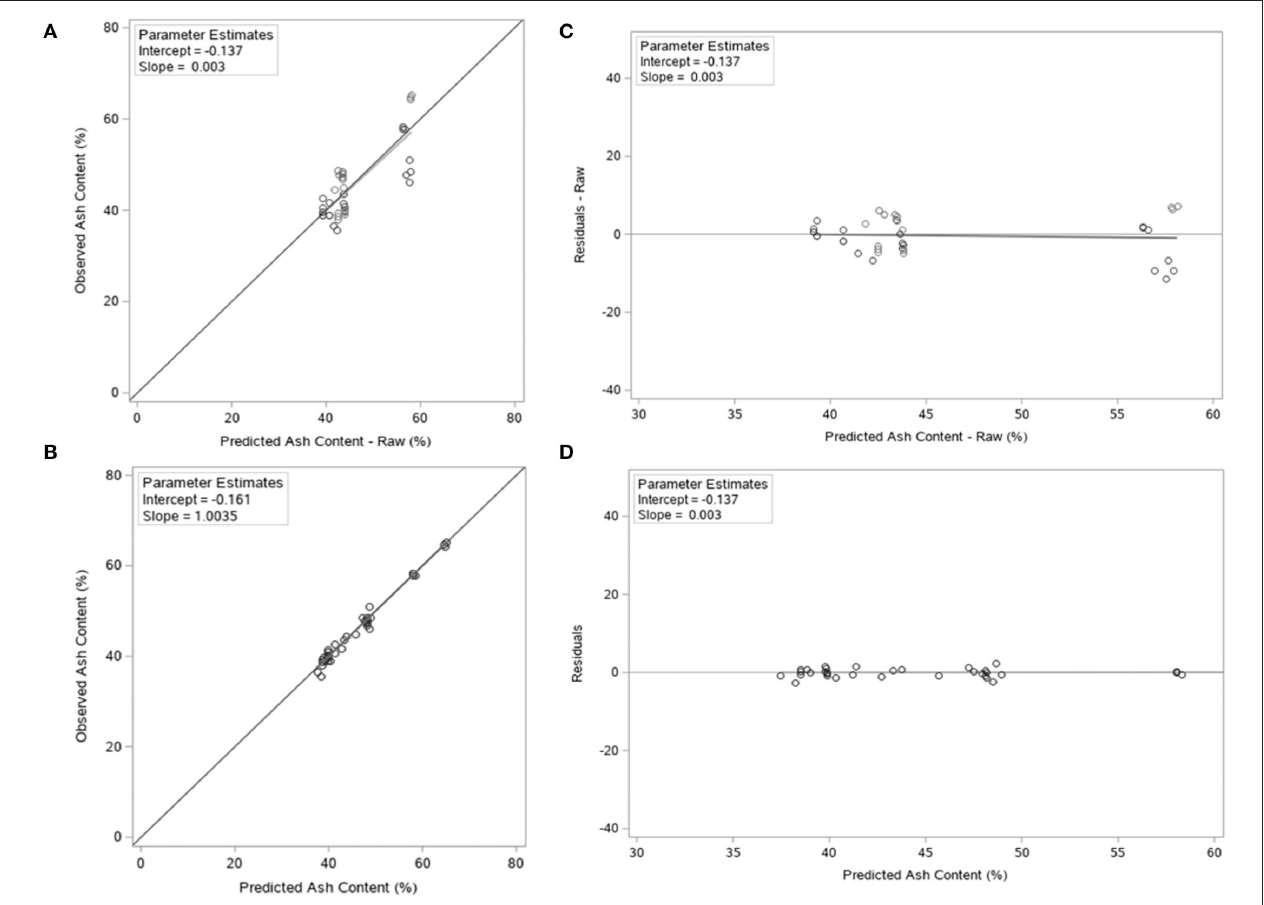
FIGURE 2 | (A) Observed vs. raw predicted values plot for the model equation. (B) Observed vs. conditional predicted values plot for the model equation. (C) Raw residuals vs. predicted plot for the model equation. (D) Conditional residuals (predicted – observed) vs. predicted plot for the model